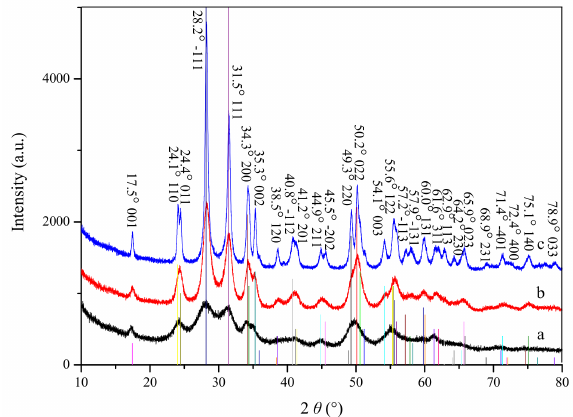
Figure 1. XRD patterns of as-synthesized ( a ) and calcined zirconia ( b ): calcined at 723 K; ( c ): calcined at 923 K, vertical line: PDF#37-1484.